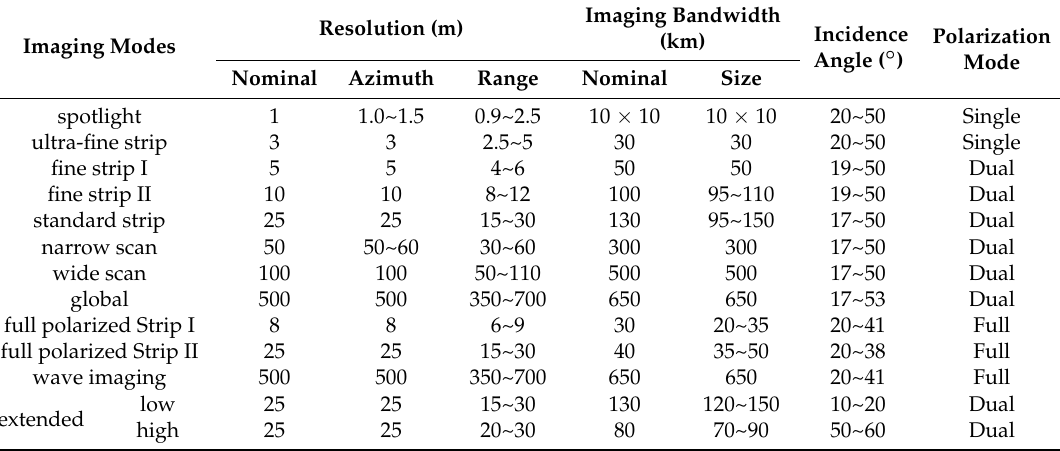
Table 1. Main technical specifications of Gaofen-3 satellite.